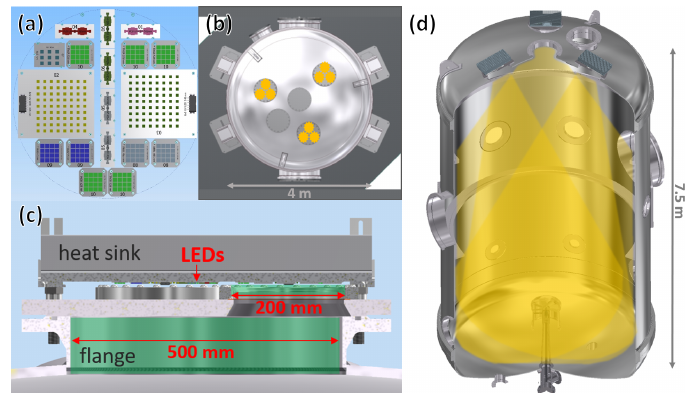
Figure 1. (a) LED board placement matching one 200mm window. (b) Three of these patches are placed on one heat sink above the 500mm flange with three 200mm quartz windows. (c) Placement of the flanges and the windows on top of AIDA. (d) Placement of the light source in relation to the whole AIDA with corresponding light